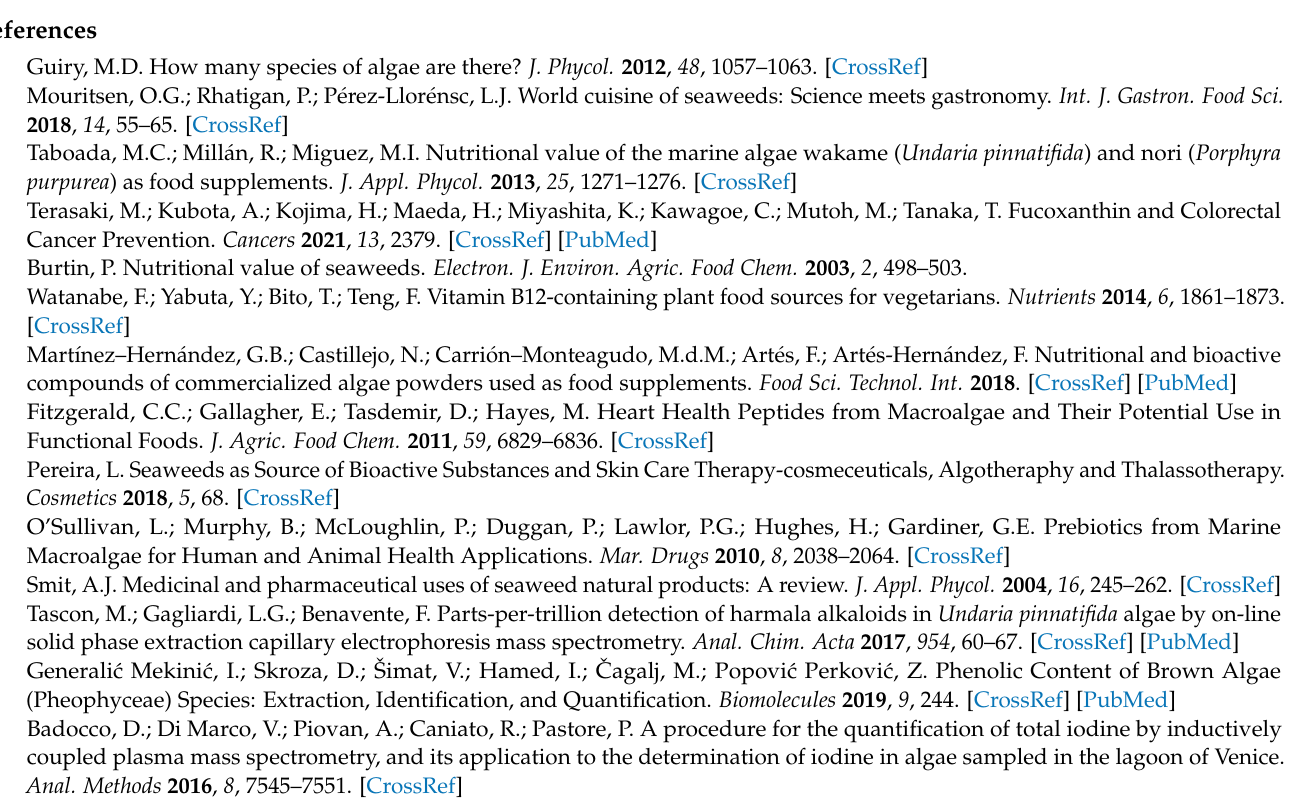
Figure S1: Molecular structures of the investigated lipid classes. Sulfoquinovosyl diacylglycerols (SQDG), digalactosyldiacylglycerols (DGDG), phosphatidylglycerols (PG), phosphatidylinositols (PI), phosphatidic acids (PA), phosphatidylethanolamines (PE), and phosphatidylcholines (PC). RPLC-ESI(-)-FTMS/MS spectra of the ions at ( A ) m/z 765.48, SQDG 14:0/16:0, ( B ) m/z 819.53, SQDG 18:01/16:0, ( C ) m/z 831.53, SQDG 19:2/16:0, and ( D ) m/z 859.47, SQDG 20:5/18:4. Figure S3: HILIC- ESI(-)-FTMS/MS spectra of the ions at ( A ) m/z 747.5, PG 16:0/18:1, ( B ) m/z 509.3, LPG 18:1, ( C ) m/z 742.5, PC 16:0/18:2, and ( D ) m/z 738.5, PE 18:0/20:4. Figure S4: HILIC-ESI(-)-ITMS/MS spectra averaged under the four chromatographic peaks related to the ion at m/z 478.3, identified as ( A ) LPE 18:1/0:0, ( B ) LPE 0:0/18:1, ( C ) LPC 16:1/0:0, and ( D ) LPC